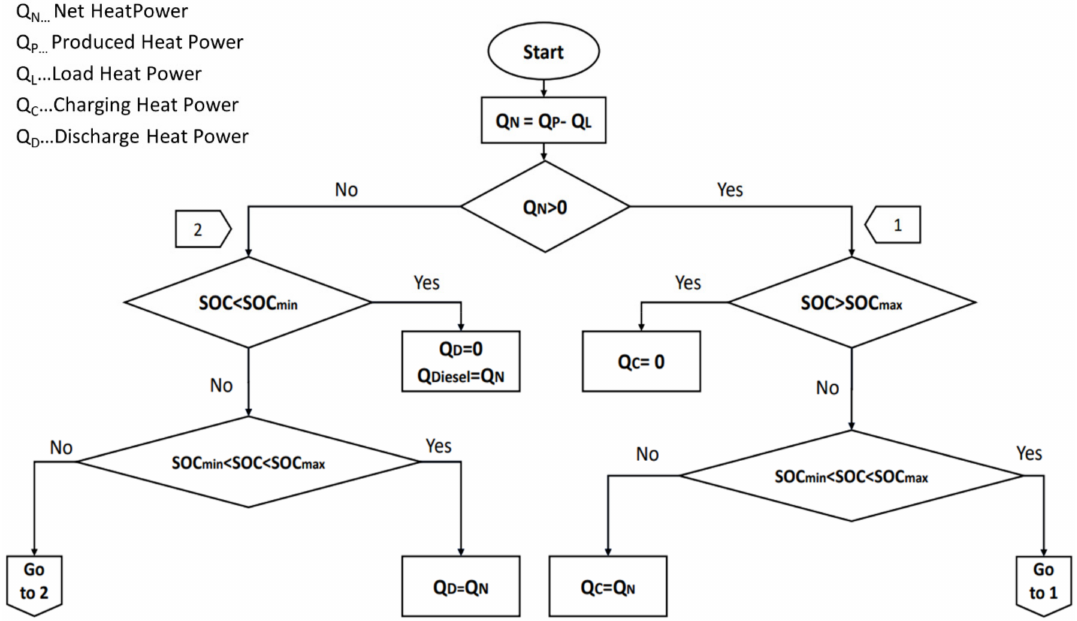
Figure 7. Flow chart of the proposed algorithm for the thermal part of the HPS controlled by the thermal